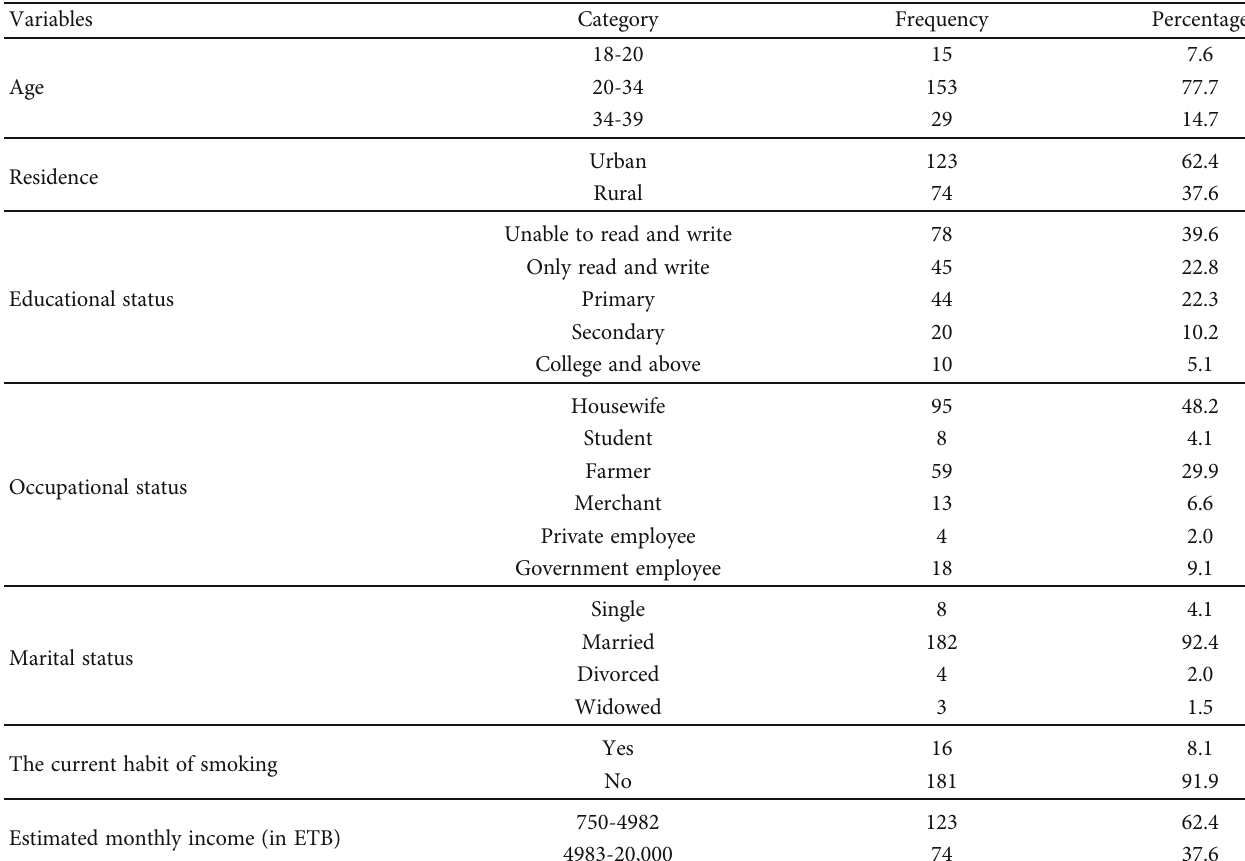
Table 1: Sociodemographic characteristics of the pregnant women in Wolkite comprehensive specialized hospital, Gurage zone, southern Ethiopia,